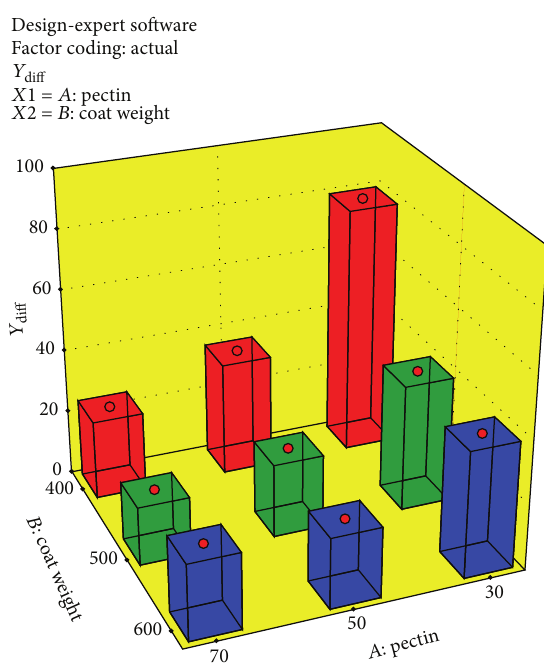
Figure 4: Effect of pectin and coat weight on 𝑌